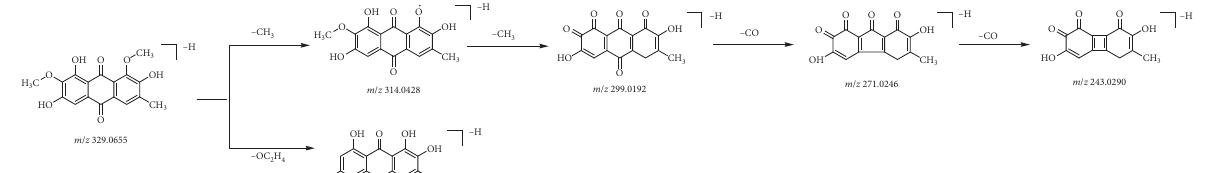
Figure 1: The fragmentation pattern of AO in negative